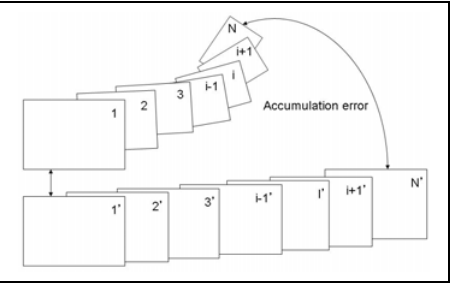
Figure 4. Mosaic strip can be fixed at its “should-be” position with the given control information in the first and last image, and the accumulation error can be derived as the offset of the last image of curled strip and its ground